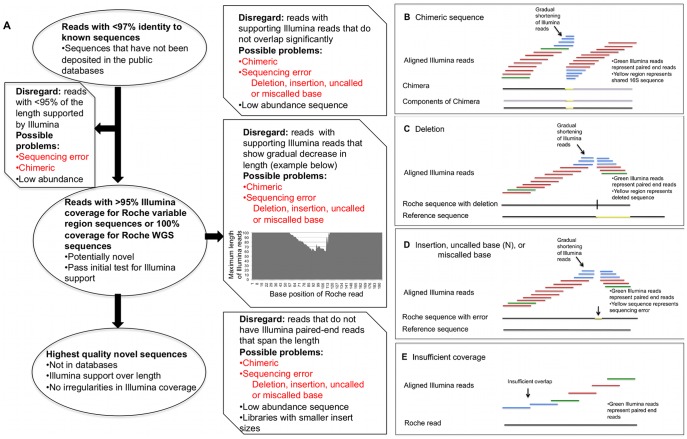
Irregularities in Illumina coverage used to identify chimeras and sequencing error.(A) This flow chart describes the removal of Roche WGS and variable region sequences based on characteristics of the Illumina alignments, resulting in a final set of high-quality novel sequences. Possible problems listed in red indicate errors in the Roche sequence, and possible problems listed in black indicate situations in which the Roche read may be of high quality but could not be confirmed by aligned Illumina sequences. The inset plot shows an example of a Roche variable region sequence with a progressive shortening of aligned Illumina sequences. The base position of the Roche sequence at which the Illumina alignment begins is plotted on the x-axis, and the maximum length of aligned Illumina reads with the given start position is plotted on the y-axis. In the middle of the Roche sequence, the Illumina sequences decrease to approximately 60 bp before returning to 100 bp in length. Characteristics of the Illumina alignments associated with specific problems with the Roche WGS and variable region reads are illustrated in B–D.